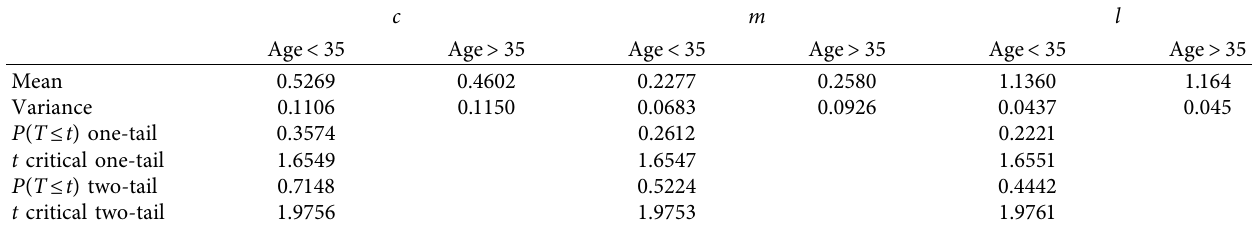
Table 2: Two-sample t -test of CF parameters between the men groups categorized based on age.